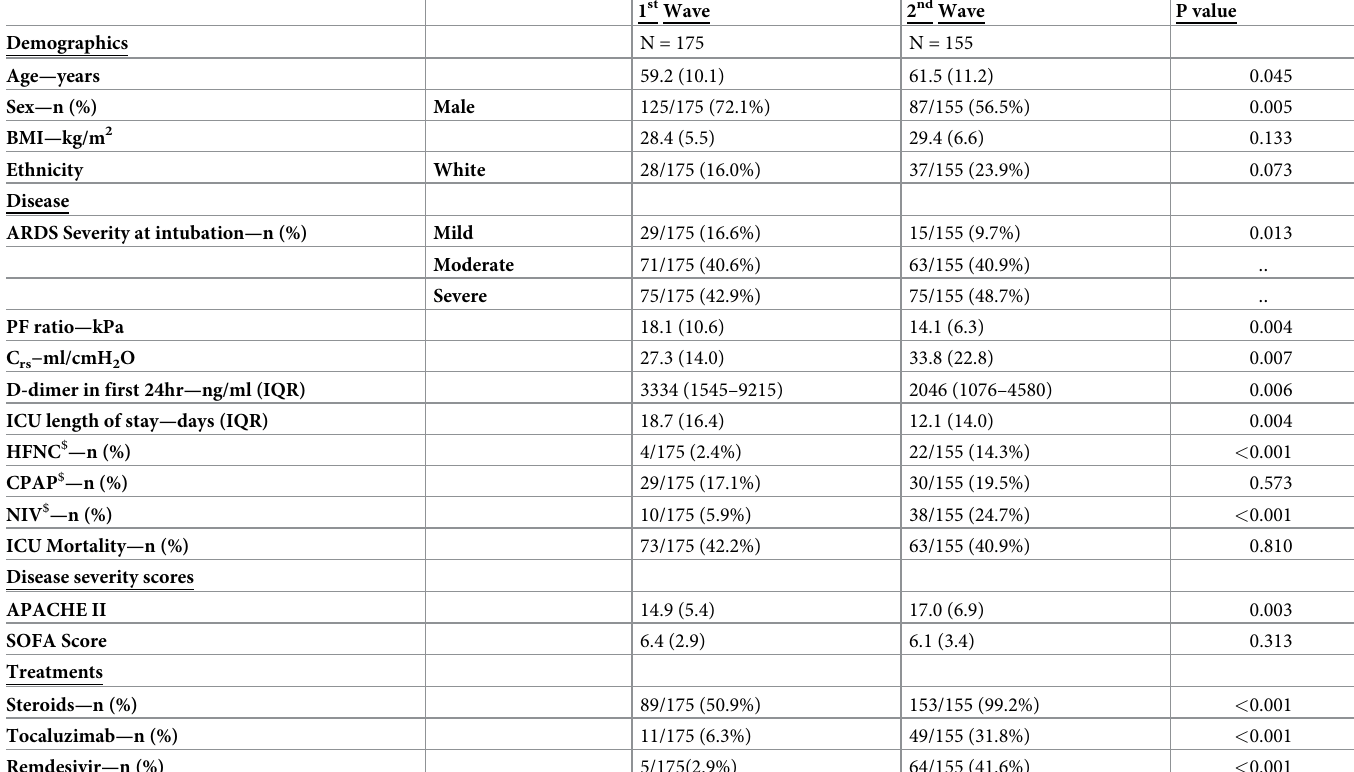
Table 1. Key demographics, ventilation parameters, treatment and disease severity scores, by UK pandemic wave.